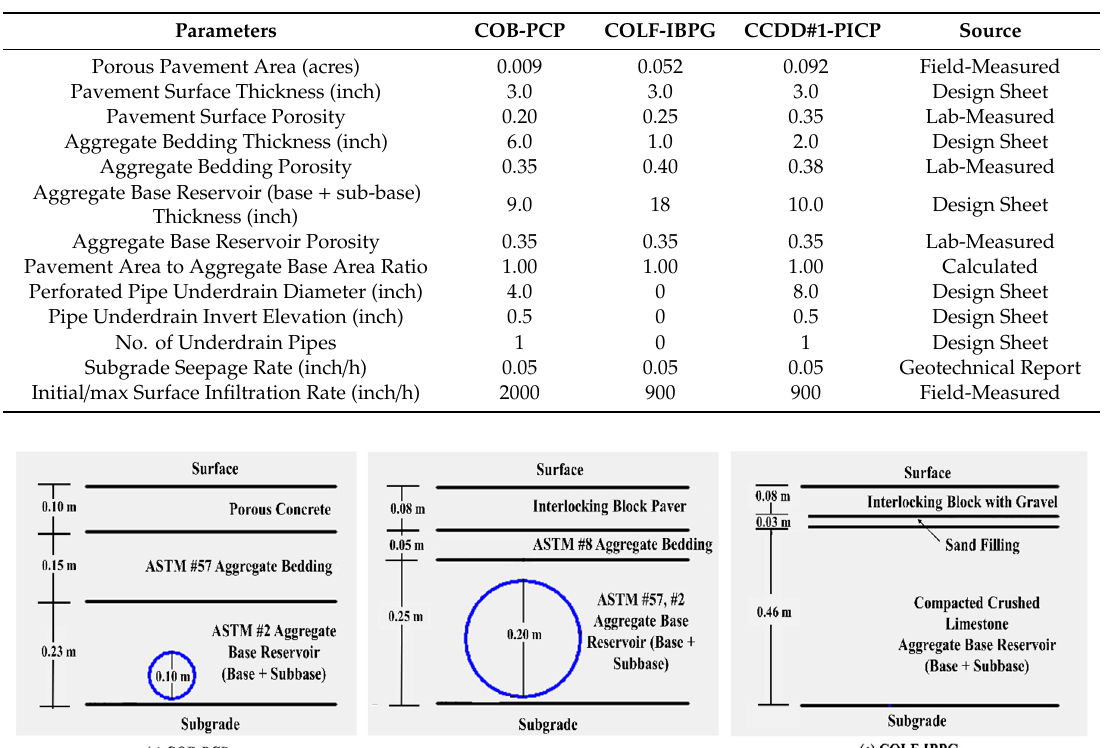
Figure 3. As-built cross-sectional schematics of the three different permeable pavement systems monitored in the LRGV. From the left: ( a ) City of Brownsville (COB)-Porous Concrete Pavement (PCP), ( b ) Cameron County Drainage District#1 (CCDD#1)-Permeable Interlocking Concrete Pavement (PICP), ( c ) City of La Feria (COLF)-Interlocking Block Pavement with Gravel (IBPG).